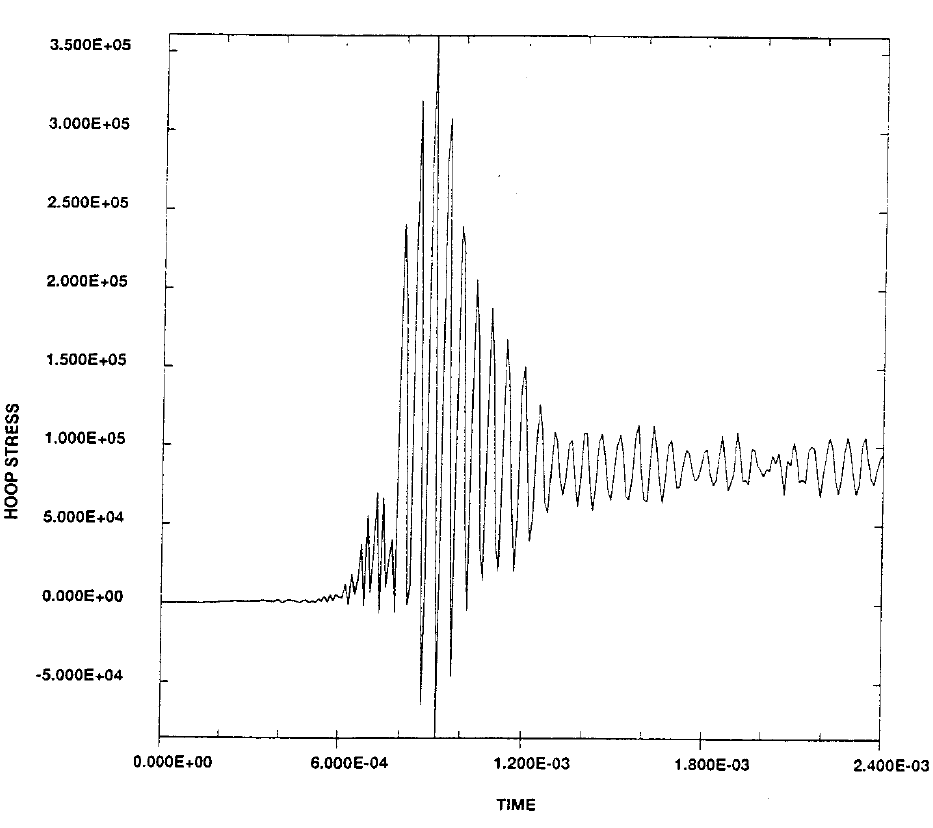
Fig. 8. Hoop stress in an element near the